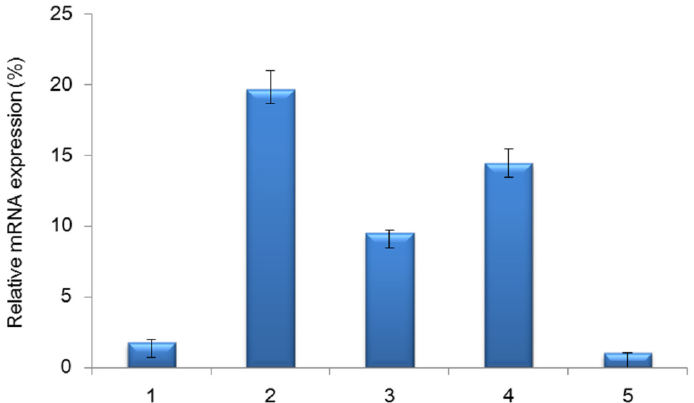
Figure 6. Spatial mRNA expression profile of Tianfu goat PPP3CA gene. The samples 1–5 represent cardiac muscle, biceps femoris muscle, abdominal muscle, longissimus dors muscle and soleus muscle, respectively. Bars represent the mean ± SD ( n =